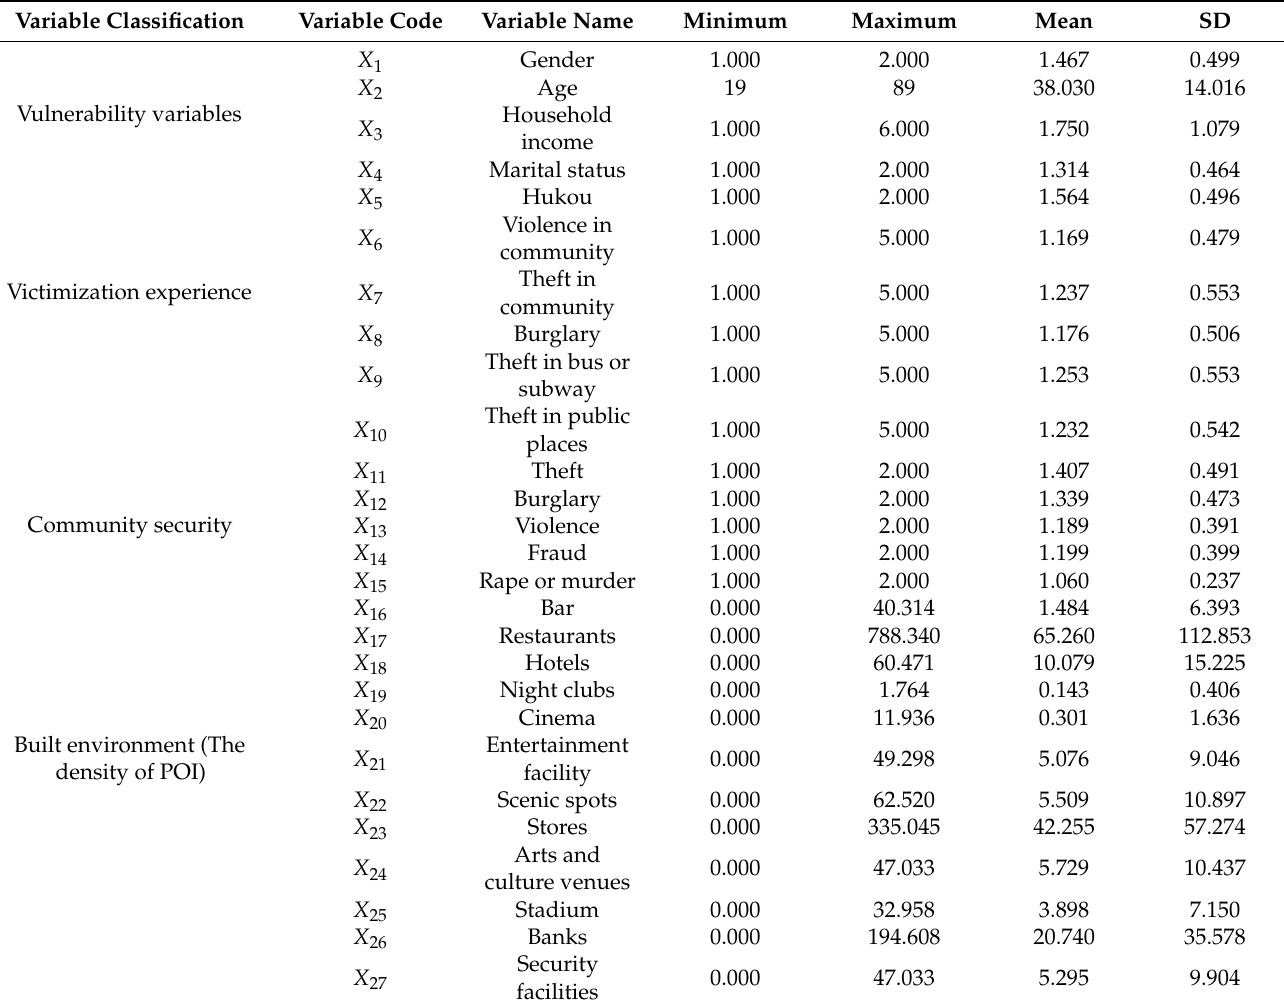
Table 2. Measurement and descriptive statistics of correlates